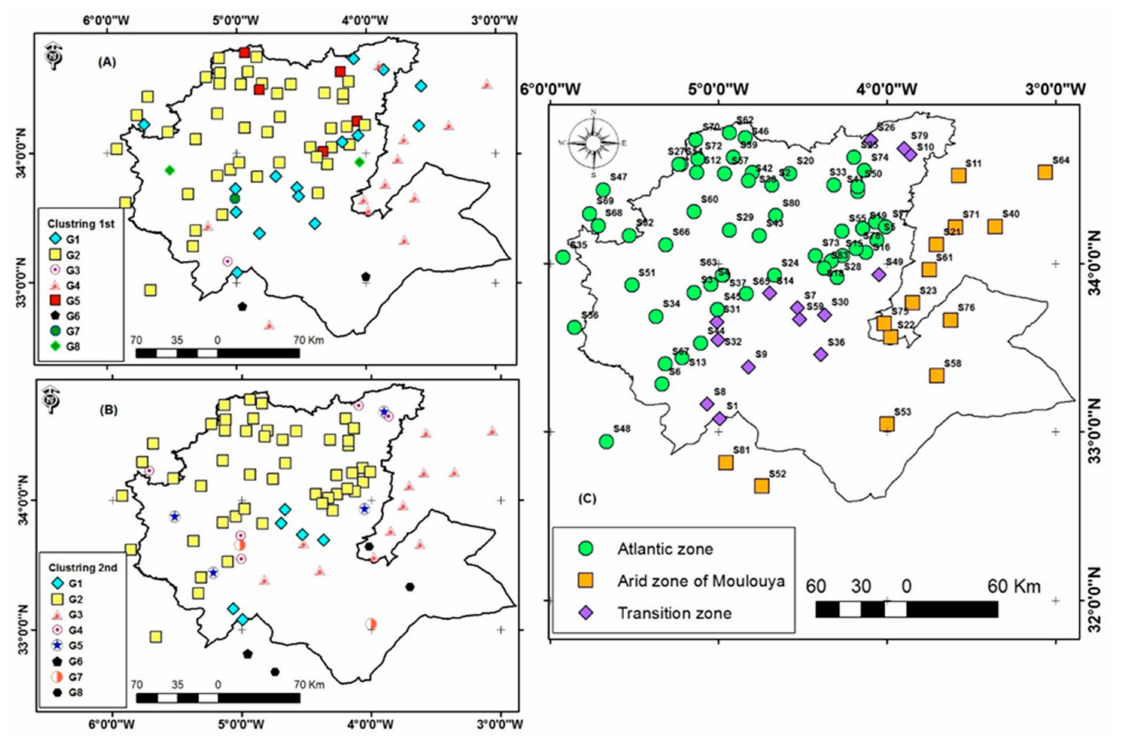
Figure 9. Clusters of stations ( A ) before and ( B ) after homogenization ( C ) generalization map. The three zones are (1) a humid Atlantic zone with a Mediterranean climate located at the west of the Middle Atlas mountain range; (2) a more arid zone to the south-east and east of the region (Upper Moulouya and Guercif basin); and (3) a transition zone between the two, located on the Atlas peaks, the Medaz basin, and the region’s northeastern tip (Figure